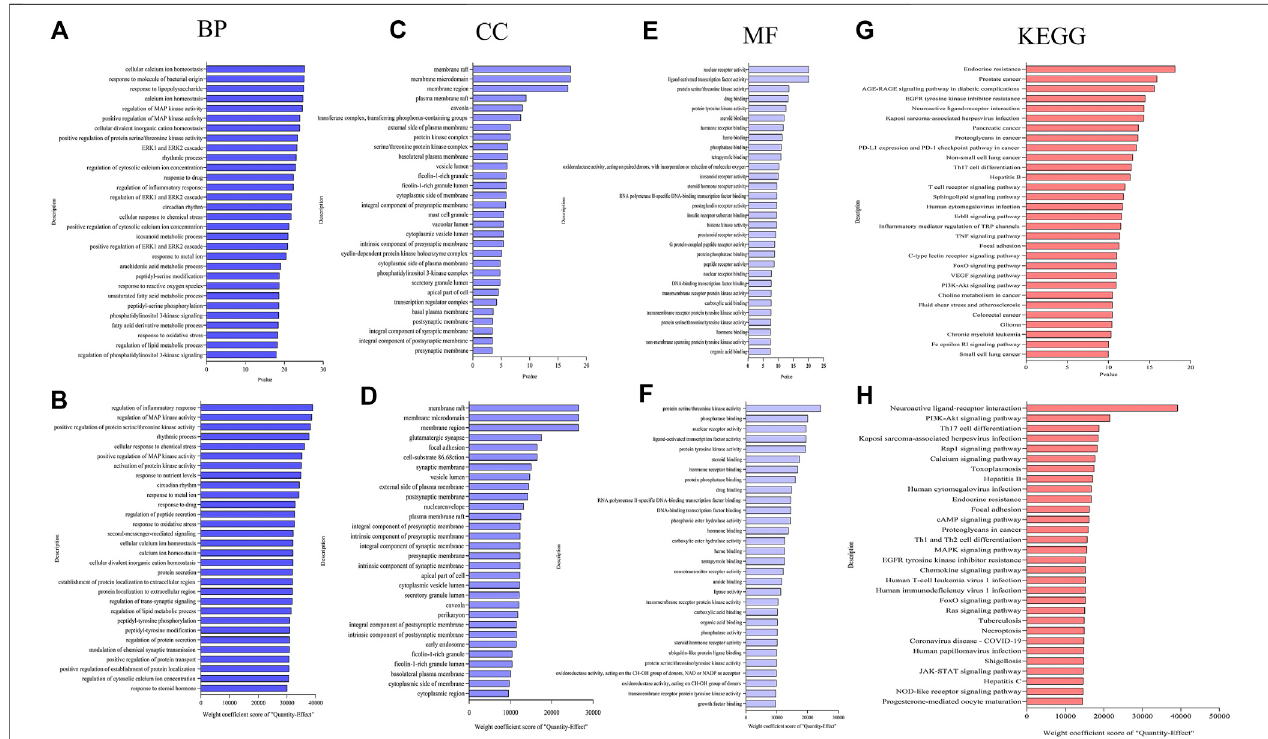
FIGURE 3 | (A – F) Biological process (BP), cellular component (CC), and molecular function (MF) of lavender essential oil before and after weight coef fi cient calculation were analyzed. (G, H) KEGG enrichment analysis of target compounds in lavender essential oil before and after ranking by weight coef fi cient algorithm.